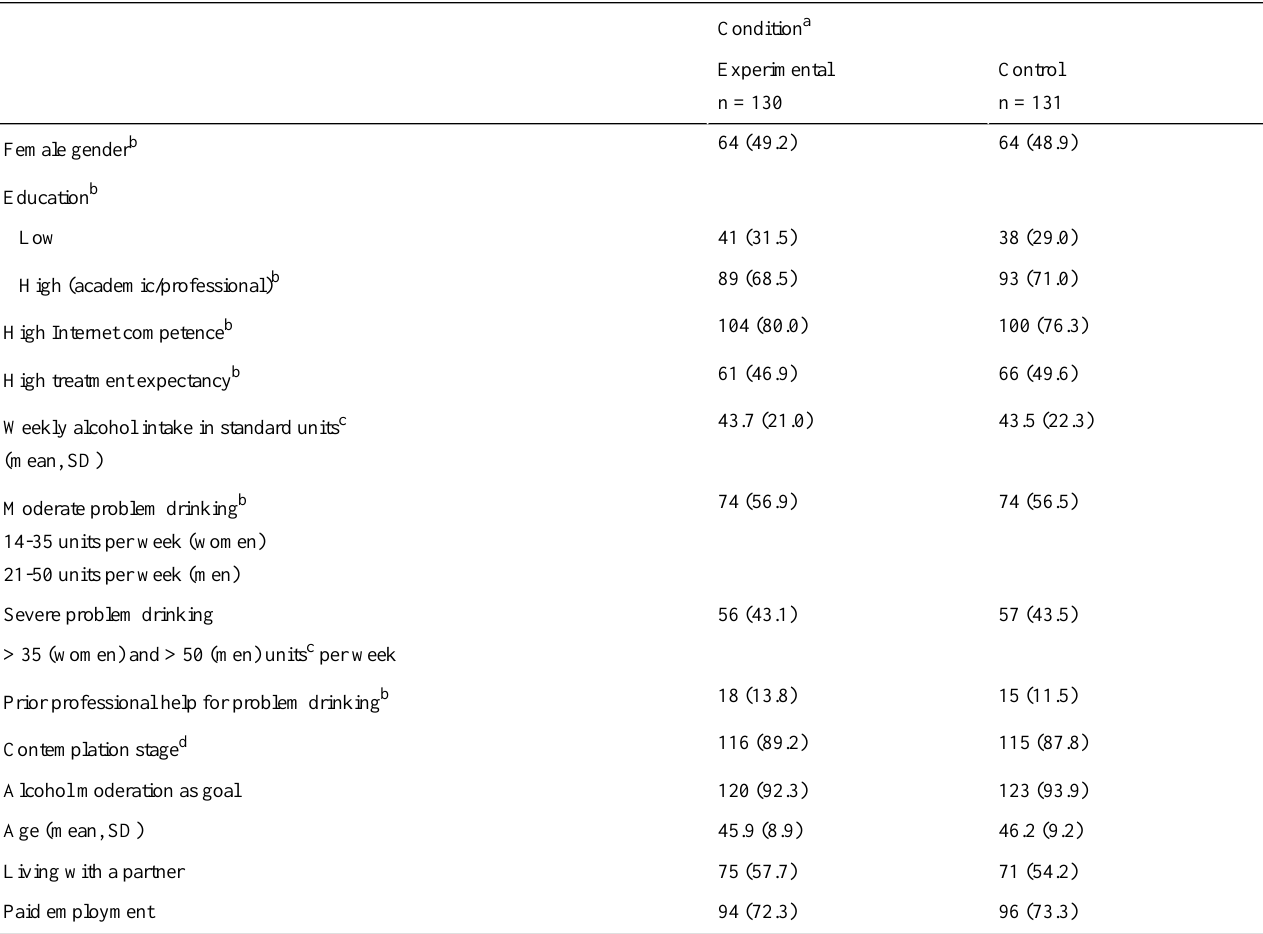
Table 1. Baseline characteristics of the 261 participants (values are numbers and percentages of participants, unless otherwise